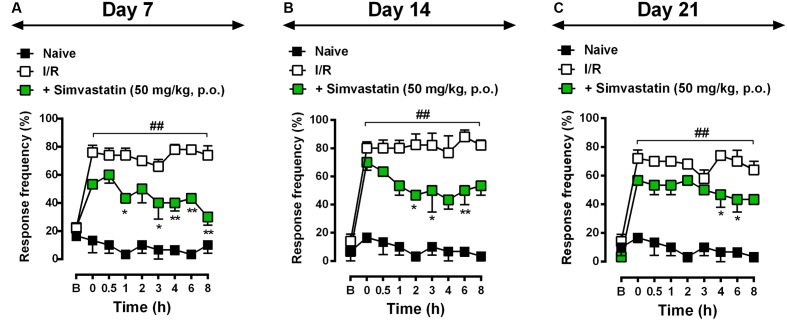
Simvastatin repeated treatment prevented the development of neuropathic pain induced by CPIP. CPIP was induced via a 3 h hindpaw I/R injury, and animals treated with simvastatin (50 mg/kg, 1x/day, p.o.) evaluated at 7 (A), 14 (B), and 21 (C) days after nerve injury. Imipramine (20 mg/kg, i.p.) was used as positive control drug. Response of frequency of the ipsilateral withdrawal thresholds assessed at several time-points by von Frey hair test. (B) Baseline withdrawal threshold before I/R injury. Data are expressed as mean ± SEM (n = 6/group), and are representative of two independent experiments. ##P < 0.001 vs. naïve group, ∗P < 0.05 and ∗∗P < 0.001 vs. I/R group (two-way ANOVA followed by Bonferroni’s test).